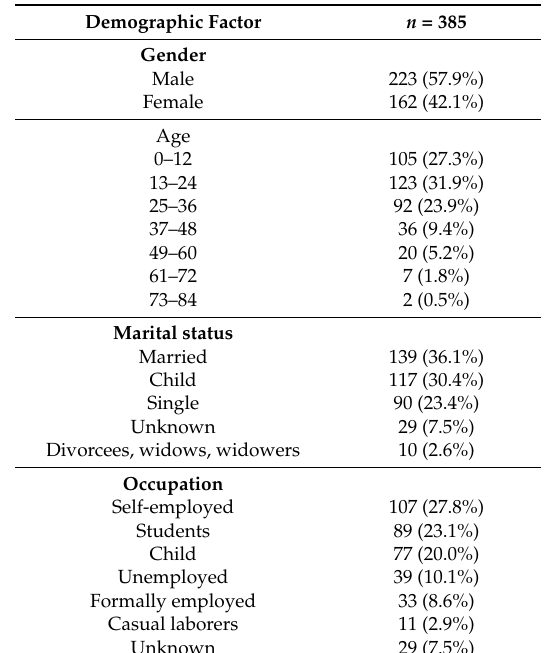
Table 1. Demographic characteristics of victims of poisoning at Jaramogi Oginga Odinga Teaching and Referral Hospital (JOOTRH) during the study